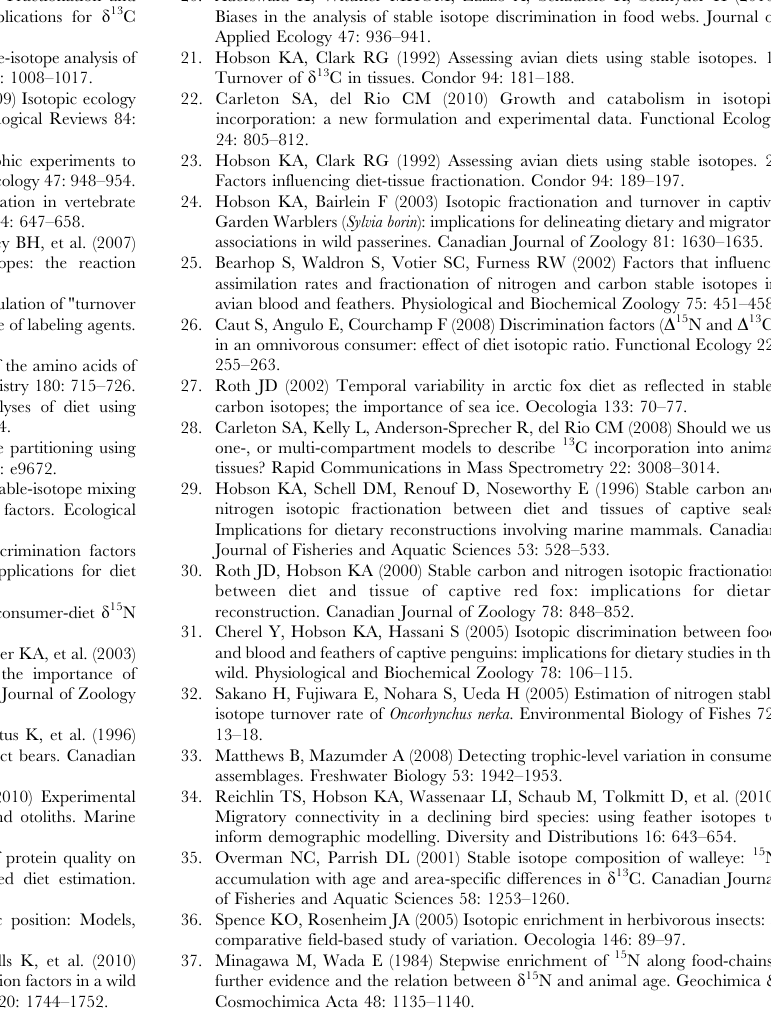
trajectory corresponds to one individual (n= 20). See methods for details. Figure S2 Example of possible output from Turnover- Sim, a R-script to model tissue turnover. The script provides boxplots of the estimates of the three key parameters measuring turnover (asymptote, intercept and half-life) with different number of days of tissue sampling since diet shift. See Methods for further details. Table S1 Factors affecting discrimination between the diet and tissues of 40 arctic foxes. Table S2 Factors affecting turnover in blood tissues of 20 farmed arctic foxes. Table S3 Dietary composition and chemical content of the three experimental diet (in % otherwise mentioned) of arctic foxes, 2007-2008, A ˚s, Norway.